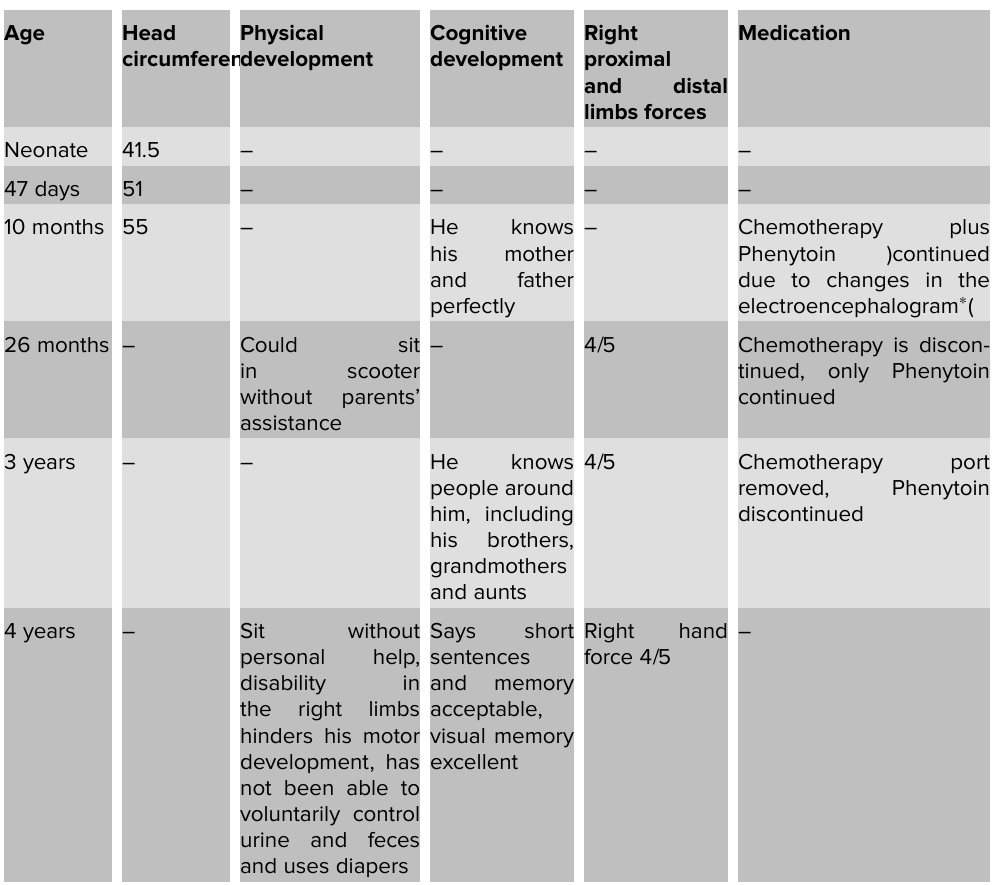
Table 1: Four-year follow-up table of a 47-day old male infant with desmoplastic infantile astrocytoma (available data relating to head circumference, physical and cognitive development and received medication are presented).